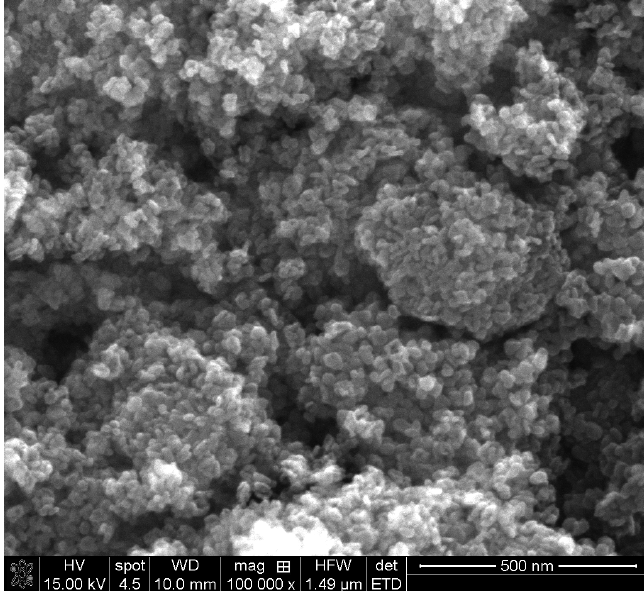
Figure 11. SEM image of the TiO 2 sensitive powder sample, from ref. [31].